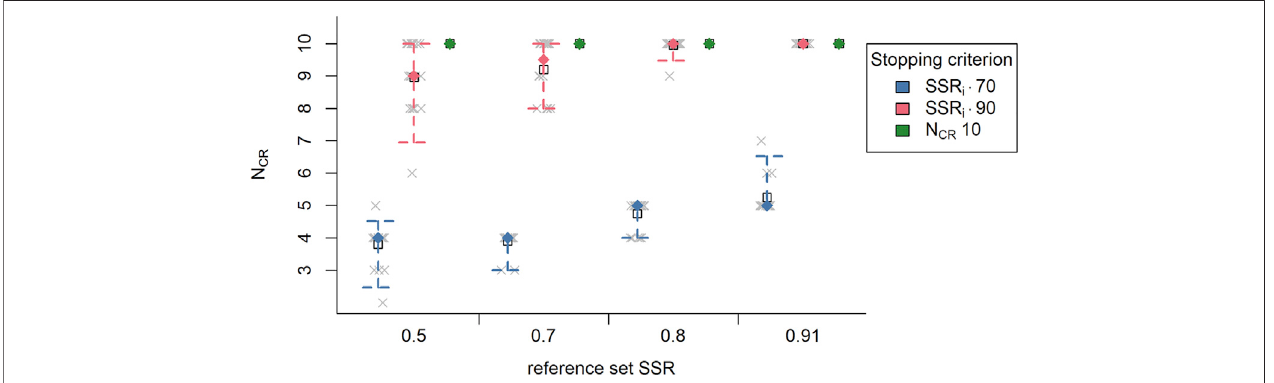
FIGURE 5 | The median ( n = 20; fi lled diamond) and average ( n = 20; empty square) number of comparisons per representation (Ncr) per reference set (SSR of referencesets)and per stoppingcriterion(colors; SSR